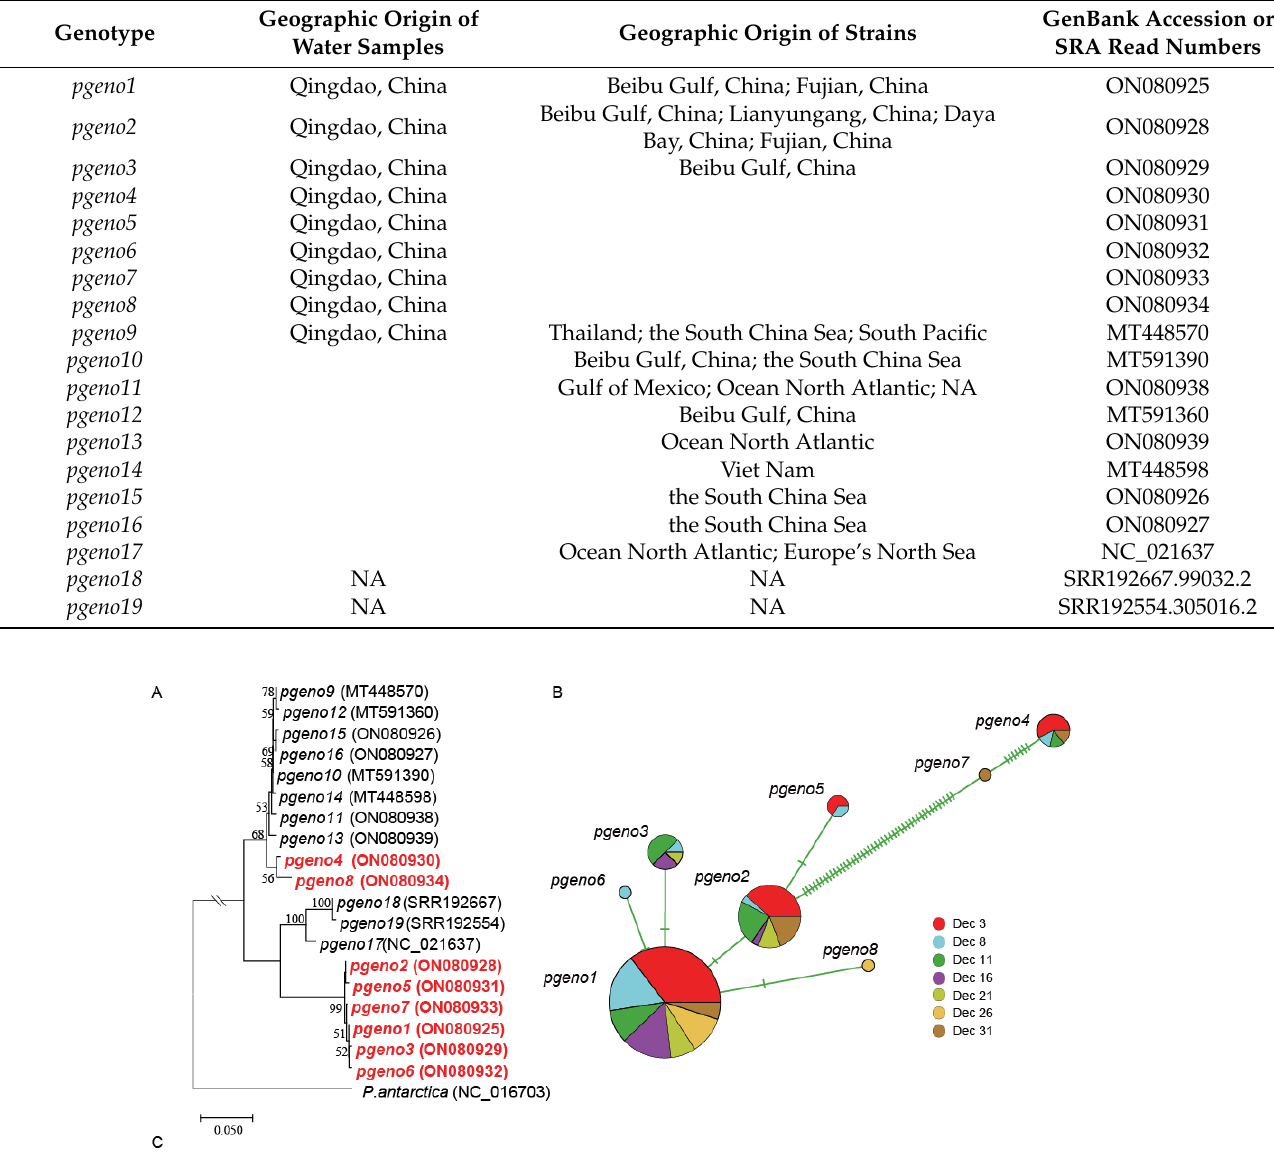
Table 1. Geographic origin and GenBank accession of pgcp1 genotype.